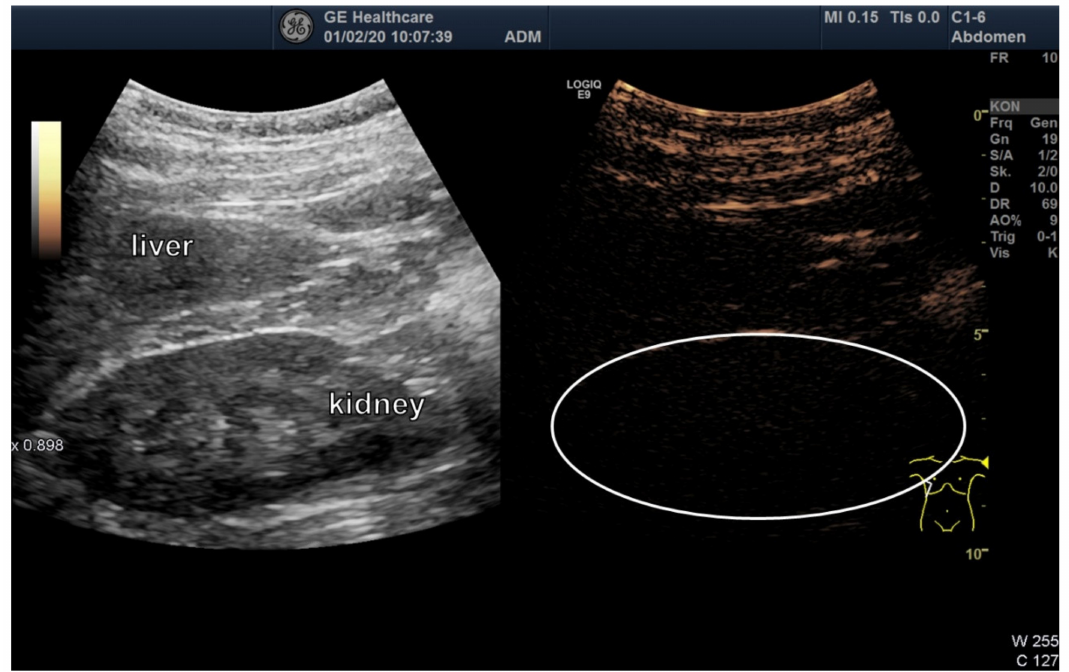
Figure 8. Ultrasound image of kidney. No enhanced signal is detected in the